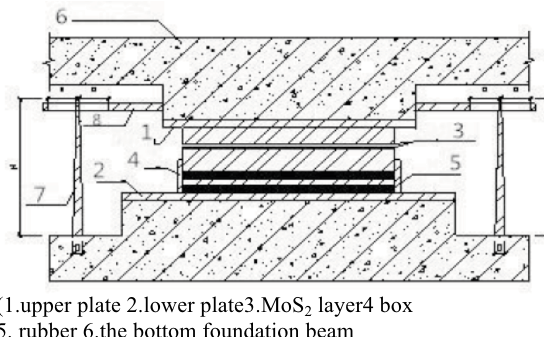
(1.upper plate 2.lower plate3.MoS 2 layer4 box 5. rubber 6.the bottom foundation beam 7.displacement restrictor 8.director plate) Figure 2. The new friction sliding isolation bearing As a good solid lubricating powder, MoS more advantages of standing high pressure and high temperature, having low friction and wide suitability of speed. For this reason, the new friction sliding isolation bearing was invented as show in Fig